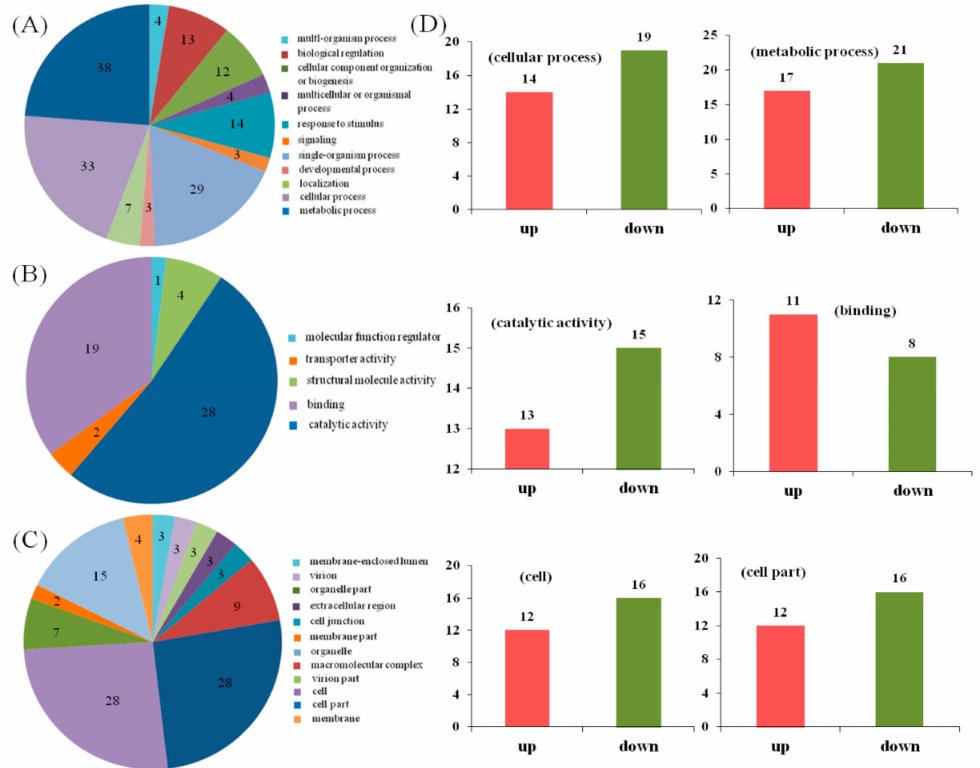
Figure 5. Gene Ontology (GO) function annotation of differentially expressed proteins between different treatments and differential expression analysis of major GO terms. ( A – C ) GO function annotation of differentially expressed proteins between different treatments, ( A ) biological process ontology; ( B ) molecular function ontology; ( C ) cellular components Ontology; and ( D ) Differential expression of major GO terms in different ontology between treatments according to the criteria of |Fold change| > 1.2 and p -value < 0.05, which is used to determine whether there is a difference in the expression levels of proteins between different